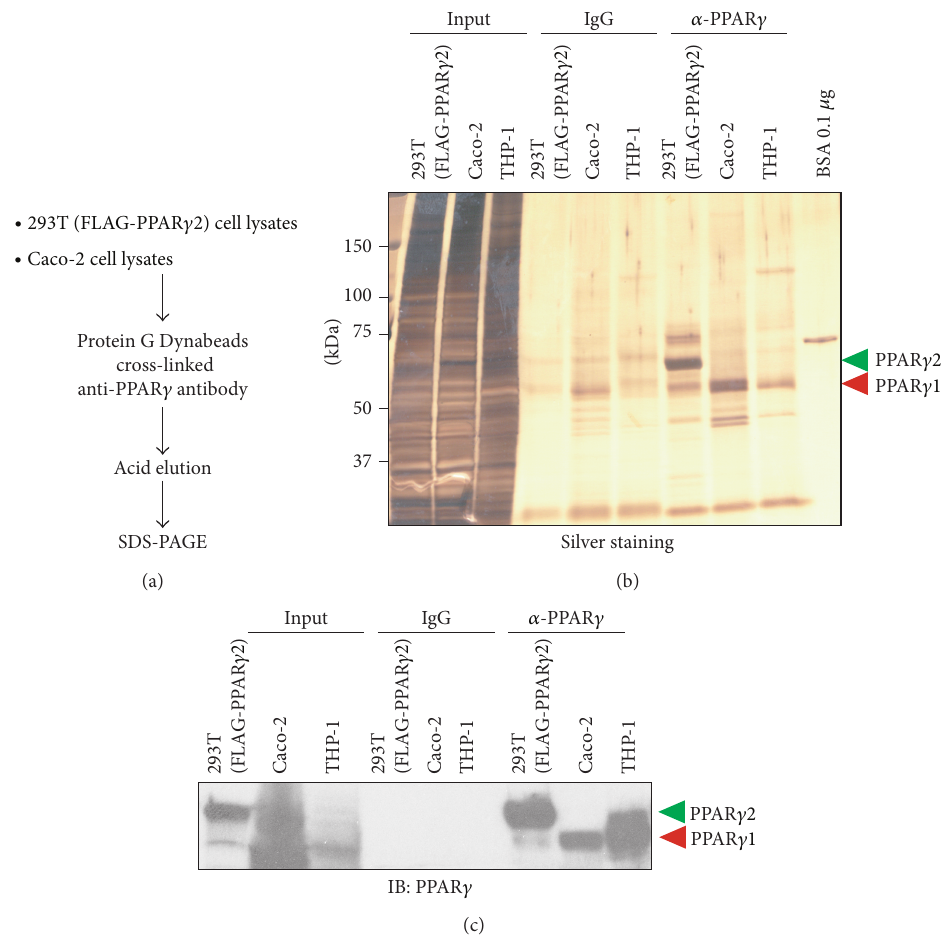
Figure 1: Purification of PPAR 𝛾 proteins from 293T and Caco-2 cell lysates. (a) Schematic diagram of the purification of the exogenous and endogenous PPAR 𝛾 proteins. 293T and Caco-2 cell lysates were incubated with anti-PPAR 𝛾 cross-linked Protein G Dynabeads as described in Section 2. Rabbit IgG cross-linked Protein G Dynabeads were used as a negative control. Bound proteins were eluted with 0.1 M glycine- HCl buffer (pH 2). (b) Isolated exogenous and endogenous PPAR 𝛾 proteins. Eluted proteins were subjected to SDS-PAGE, followed by silver staining. The molecular masses of PPAR 𝛾 1 and PPAR 𝛾 2 are shown in the right side of the gel. (c) Enrichment of PPAR 𝛾 proteins were also confirmed by Western blotting using anti-PPAR 𝛾 specific